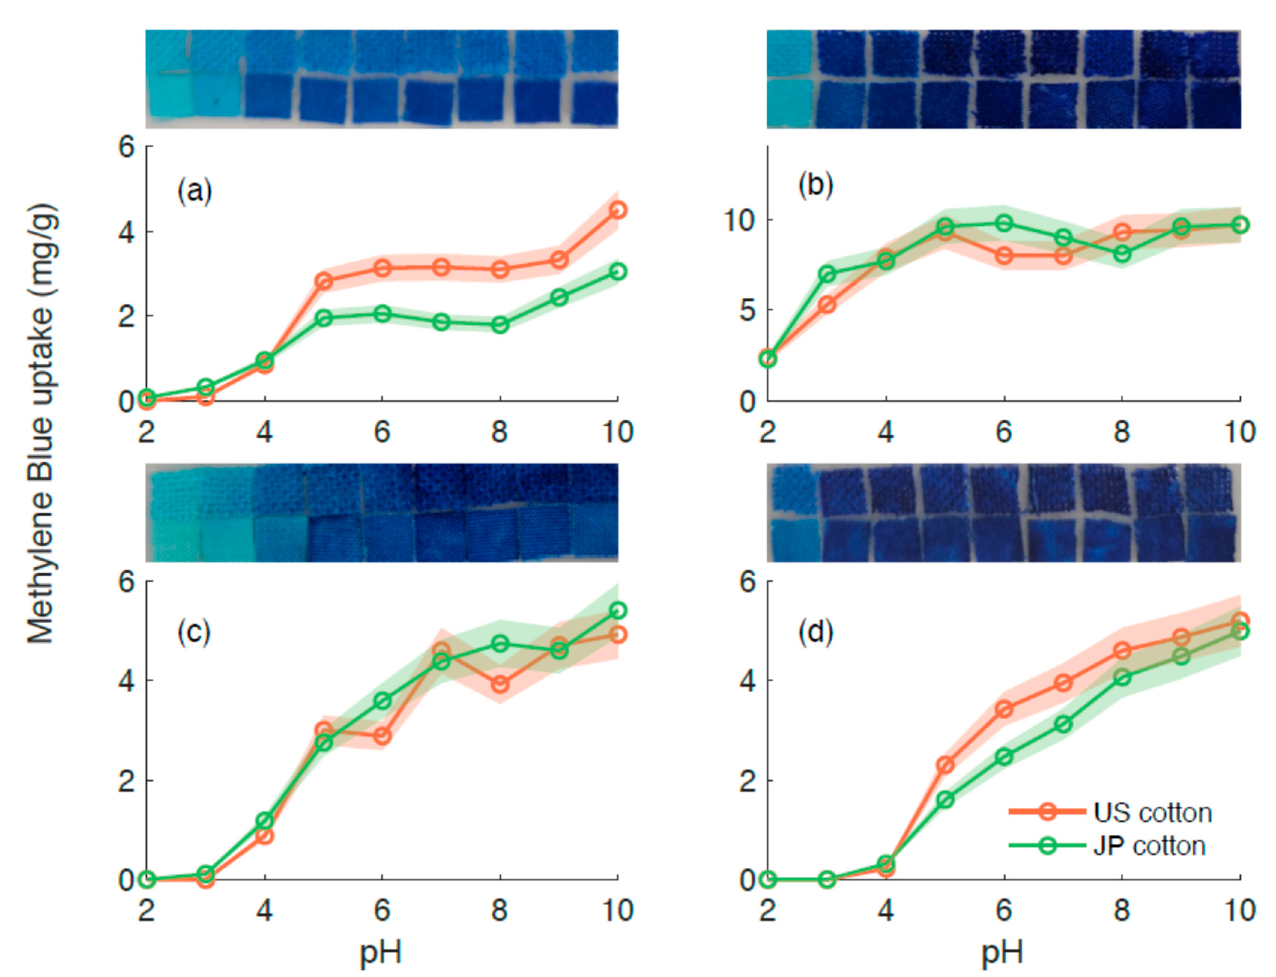
Figure 2. Methylene blue (MB) uptake and resultant color change in carboxylated cotton fabrics as a function of pH. ( a ) Untreated cotton, ( b ) oxalic acid-treated cotton, ( c ) fumaric acid-treated cotton, and ( d ) citric acid-treated cotton. Photographs of the cotton samples aligned with the corresponding pH scale are located at the top of each plot, the top row corresponds to JP cotton, and the bottom row corresponds to US cotton. The shaded areas correspond to confidence intervals.